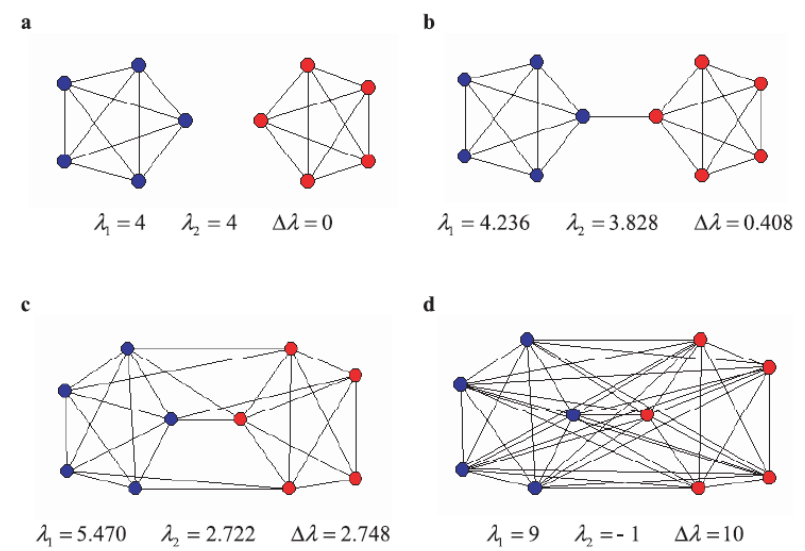
Figure 5. Spectral gap concept. ( a ), which shows a spectral gap ∆ λ = 0. The connection of these two components by a single link ( b ) represents an example of a network lacking good expansion properties due to the presence of a bottleneck. The spectral gap in this network is close to zero. The inclusion of more links between the two components of the network increases the spectral gap for network in ( c ), which reach the maximum for the complete graph ( d ), where every pair of nodes is connected to each